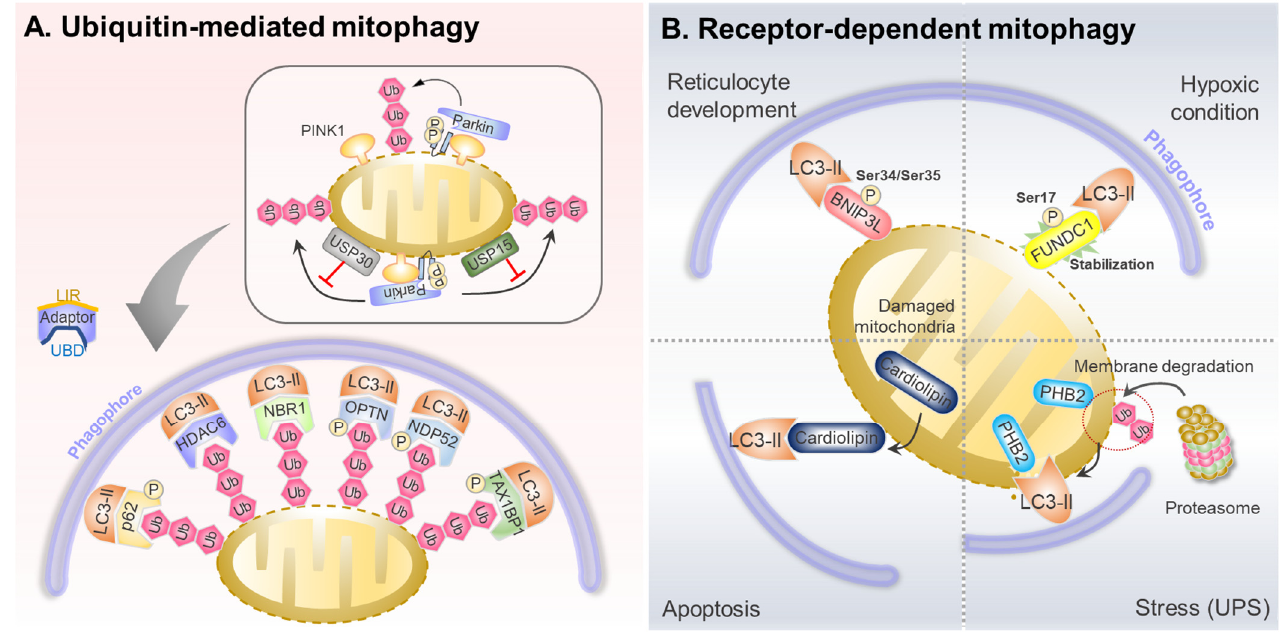
Figure 2. Receptors and adaptors of mitophagy. ( A ) Mitophagy adaptors have both LIR and UBD that interact with ubiquitin and LC3, respectively, in response to mitophagy activation. ( B ) Several mitophagy receptors facilitate mitophagy in response to various stress